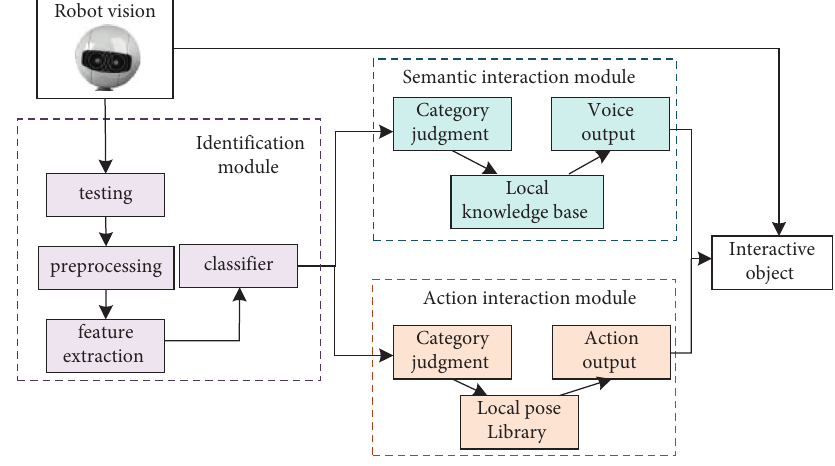
Figure 5: Overall block diagram of interactive system. Table 1: Audio module function introduction.